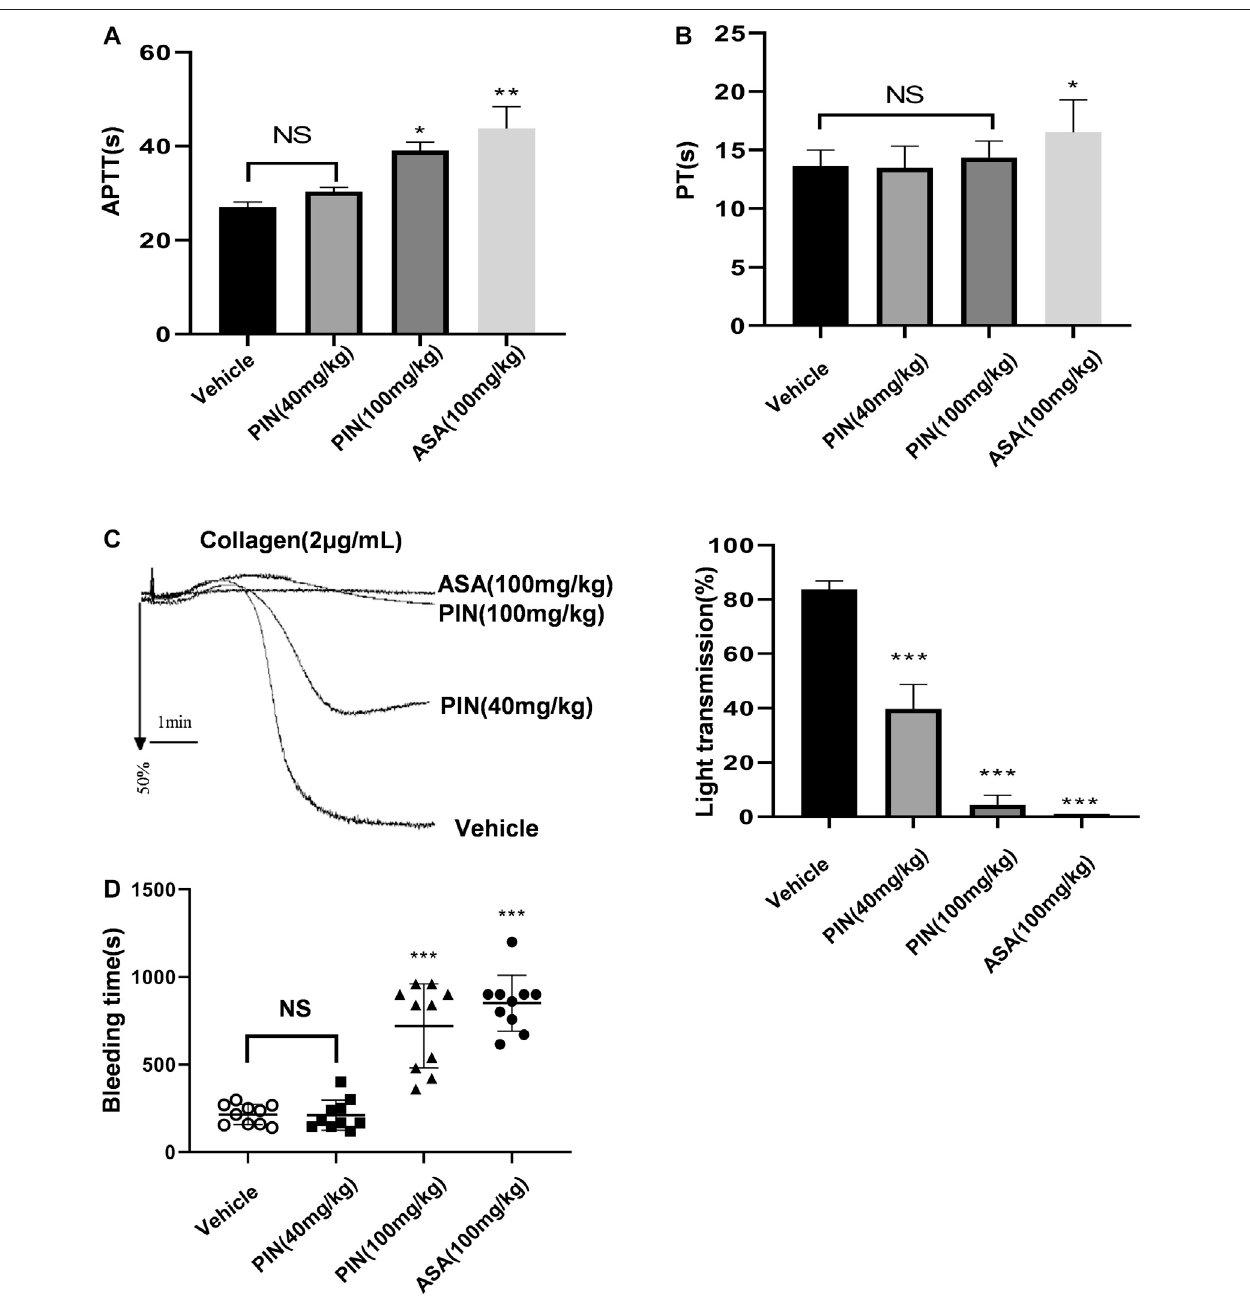
FIGURE 7 | The effects of pimpinellin on coagulation in mice. (A , B) The effect of pimpinellin on the coagulation system was assessed by the APTT and PT. (* p < 0.05, ** p < 0.01, NS means p > 0.05). (C) Representative experiments of platelet aggregation induced by collagen (2 μ g/ml) in control mice and mice treated with pimpinellin or aspirin. Pimpinellin produced a inhibition of collagen-induced ex vivo aggregation in platelets. Statistics of aggregation rates ( n (cid:2) 3). Data are presented as mean ± SEM. * p < 0.05 compared to the vehicle group. (D) The tail tip was excised and soaked at 37 ° C for the bleeding test. Symbols represent the time to stop bleeding in individual animals and error bars represent the mean ± SEM ( n (cid:2) 10).